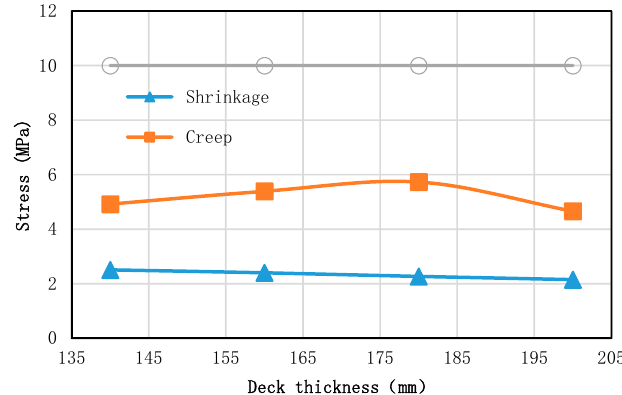
Figure 10. Stress variation in the concrete deck in the hogging region due to different effects for different deck thicknesses.